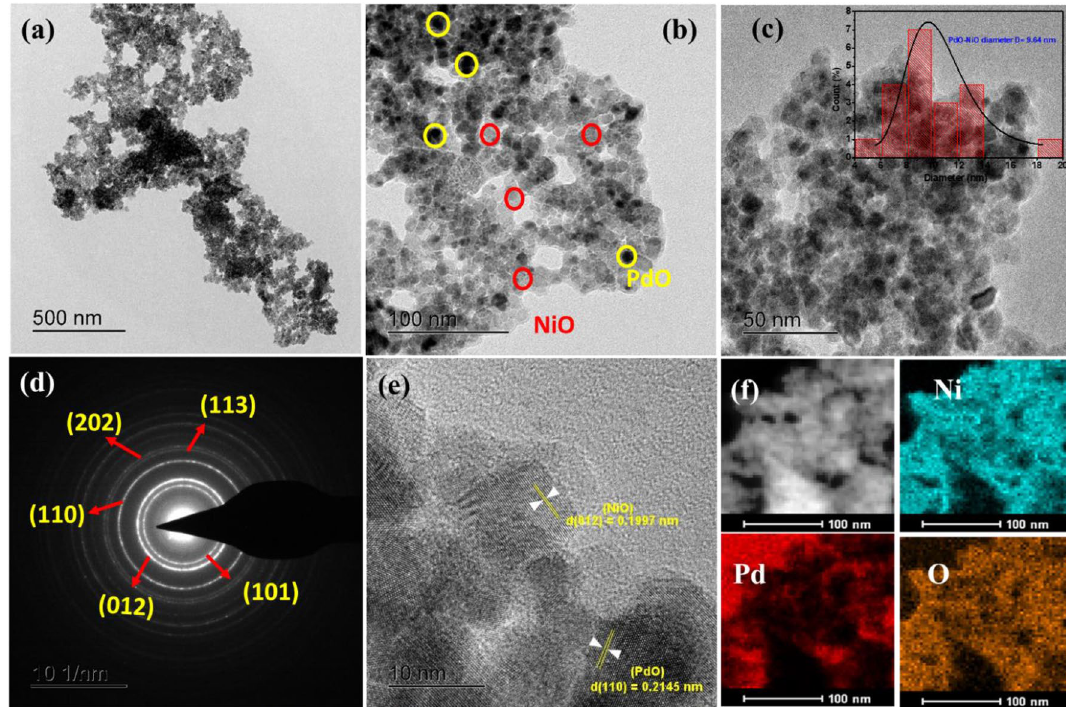
Figure 4. High resolution transmission electron microscopy HRTEM images ( a – c ), ( d ) SAED pattern, ( e ) interplanr spacing and ( f ) elemental mapping of PdO–NiO nanocomposite.